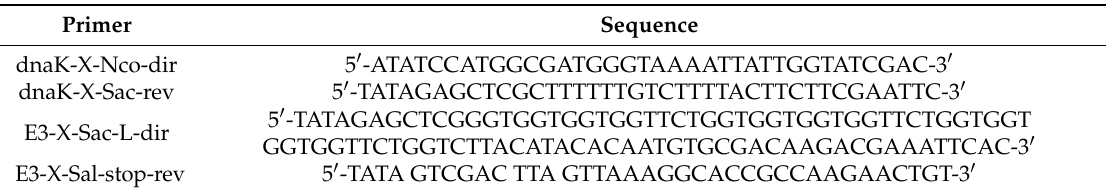
Table 1. Primers and their